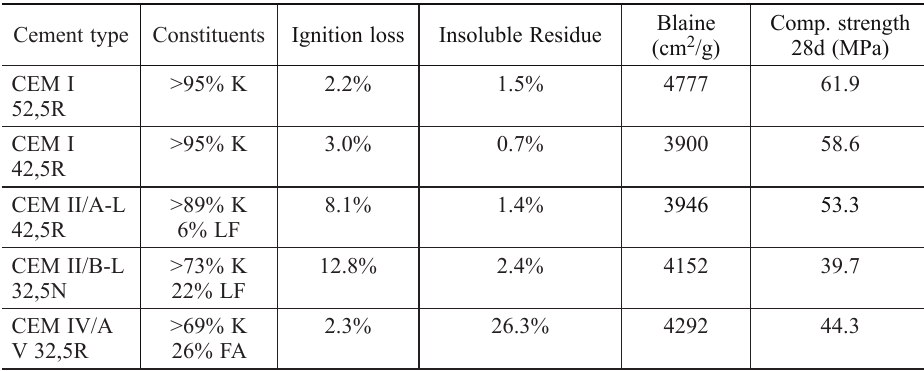
Cement type Constituents Ignition